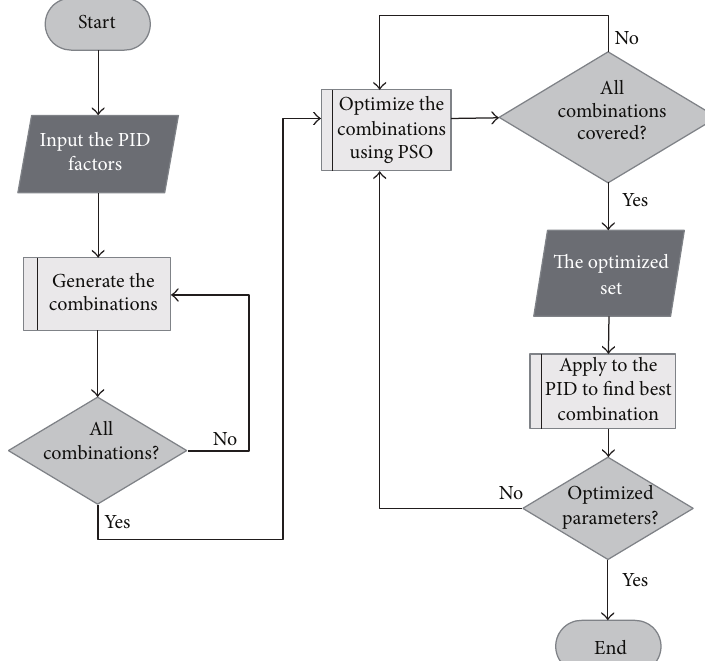
Figure 2: Process of combinatorial set construction.